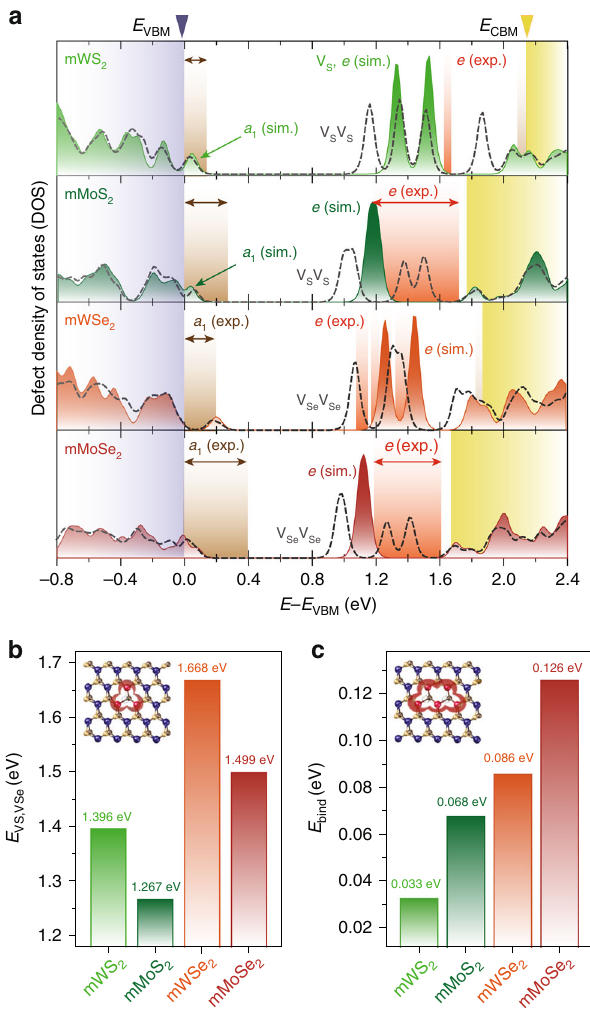
Fig. 4 DFT studies on chalcogen-atom vacancies in SC-mTMDs. a DFT- calculated locations and density of states of charge neutral a 1 and e defect- states from single chalcogen-atom vacancies in the four SC-mTMD fi lms with a consideration of the SOC effect. The defect DOS induced by double chalcogen-atom vacancies are overlaid with dotted gray lines. Tops of the valence-band edges are set at 0 eV. Note that quasiparticle energy gaps from DFT calculations are severely underestimated without the consideration of electron – electron interactions. Experimentally identi fi ed a 1 and e defect states are, respectively, overlaid with brown and orange shadows. b , c Formation ( E VS,VSe , b ) and binding ( E bind , c ) energies of individual chalcogen-atom vacancies in the four representative fi the splitting is minimal in mMoS 2 and mMoSe 2 (Supplementary Fig. 11). As experimentally and theoretically con fi rmed, the a 1